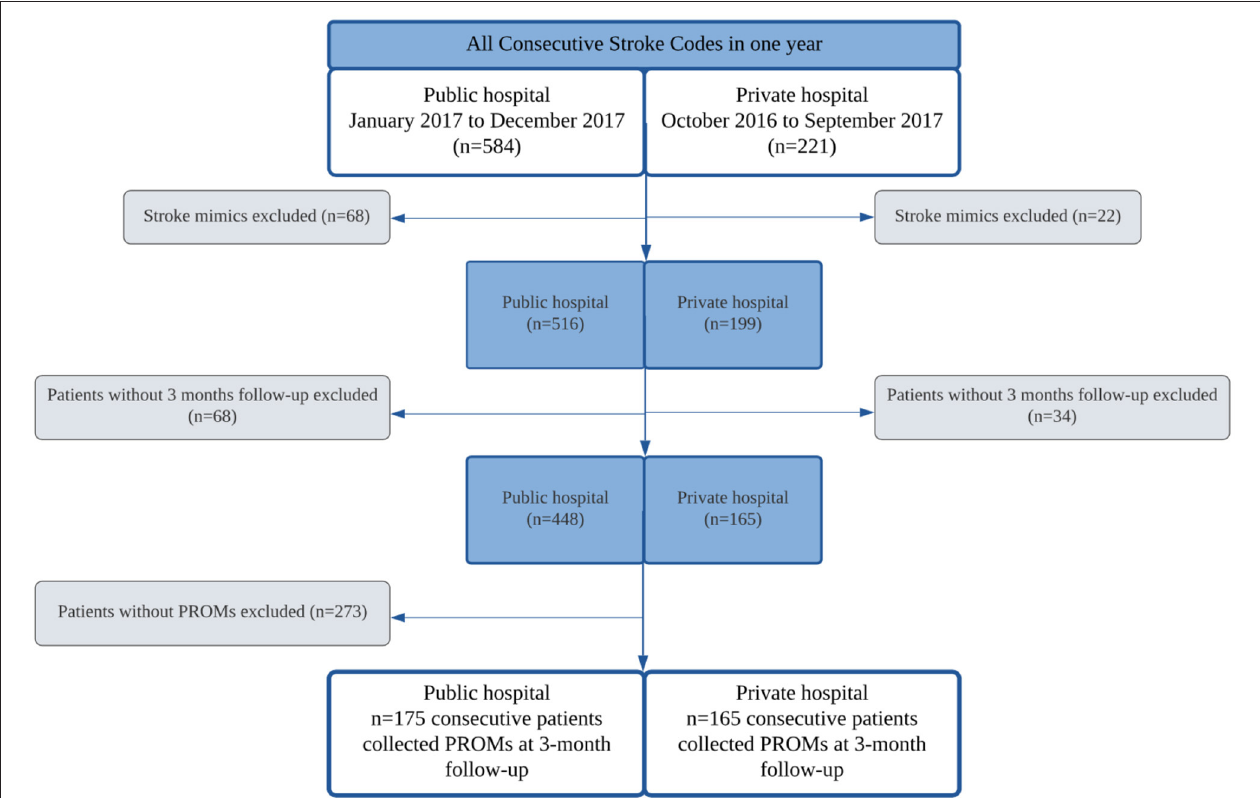
FIGURE 1 | Flowchart of the patients included in the